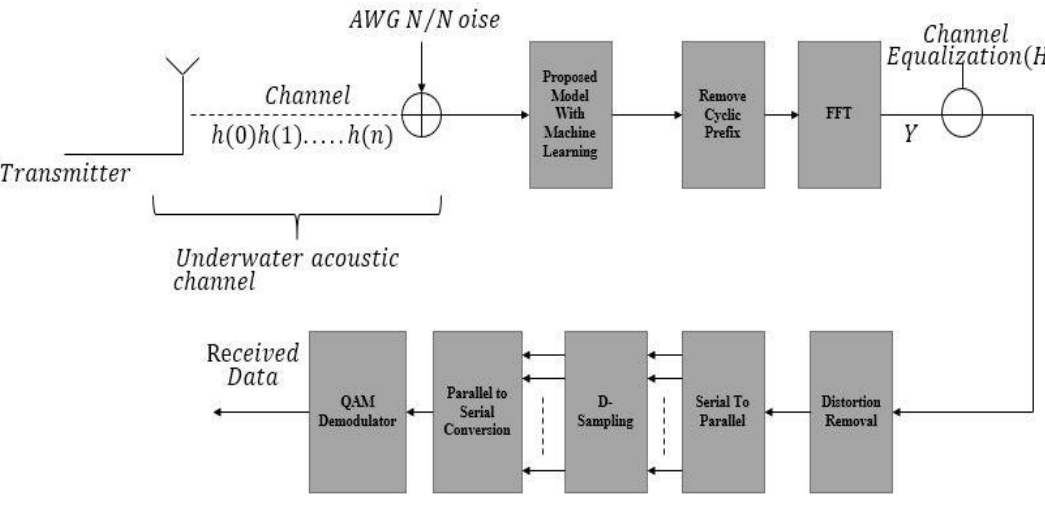
Figure 2. The framework of the OFDM